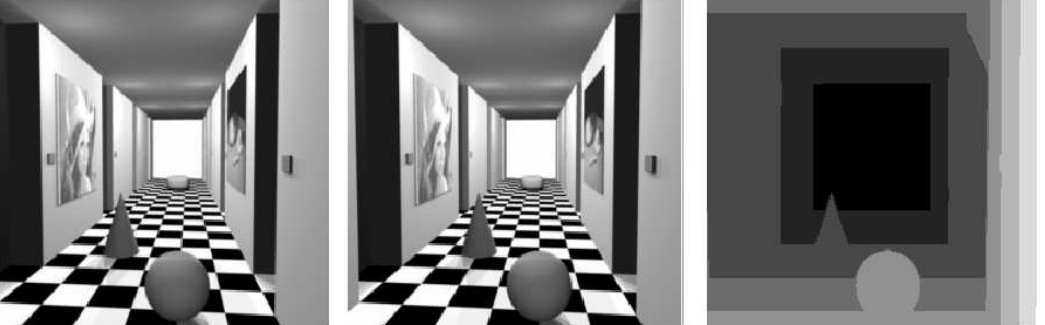
Figure 7. Tsukuba data set. From left to right: left image, right image, desired disparity